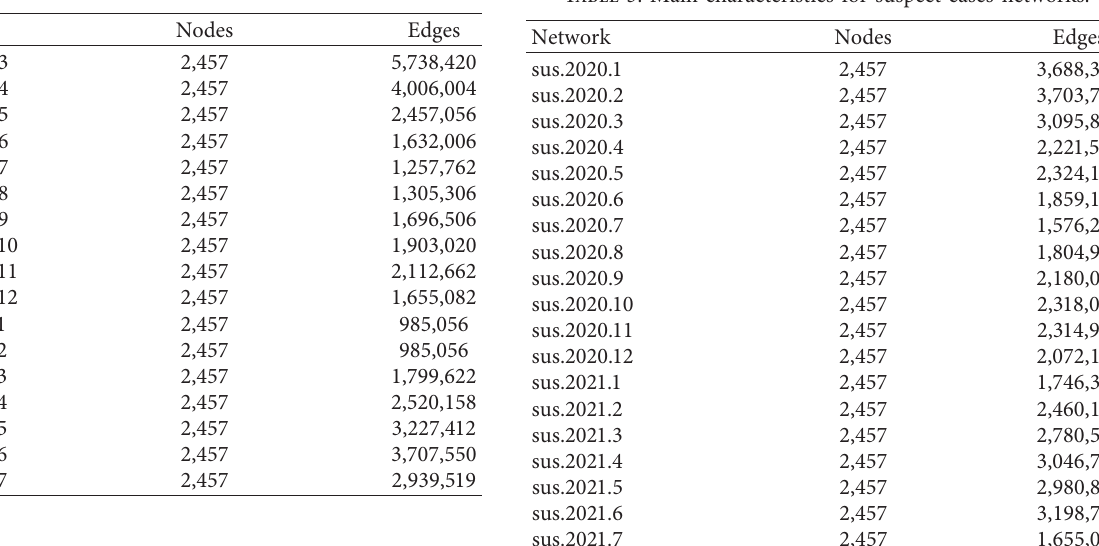
Table 4: Main characteristics for coupled networks. Network Nodes Edges